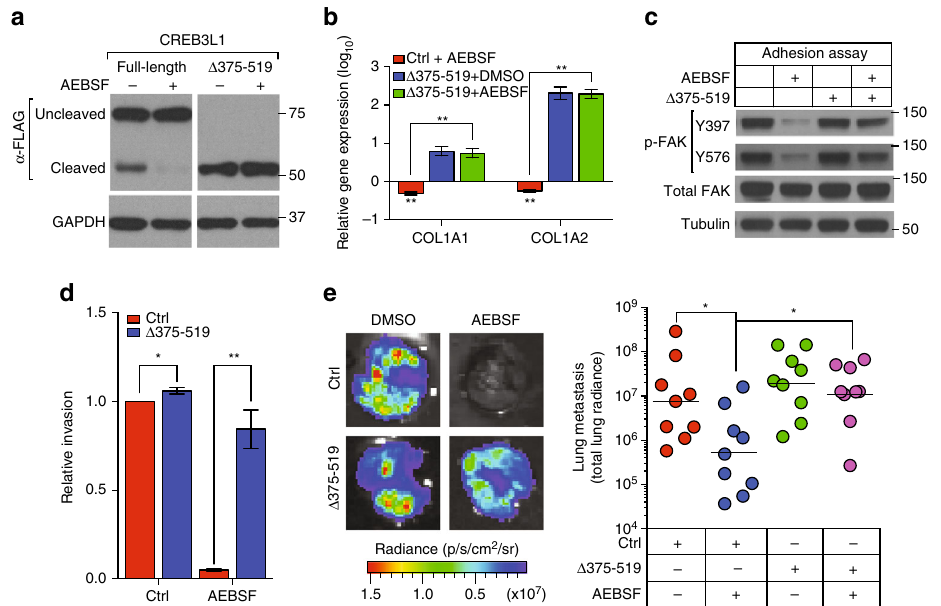
Fig. 4 Chemical inhibition of CREB3L1 blocks metastasis. a A western blot of CREB3L1 expression in full-length CREB3L1 or CREB3L1 Δ 375 – 519 transduced SUM159 cells that were treated with solvent control or a S1P inhibitor, AEBSF. b SUM159 cells transduced with control or CREB3L1 Δ 375 – 519 were treated with solvent control or AEBSF. qPCR analyses were performed to quantify the expression of ECM genes: COL1A1 and COL1A2 . The gene expression was normalized to the solvent-treated control transduction samples, n = 3. c Western blot of phosphorylated FAK (pY397 and pY576), total FAK, and Tubulin in cells of b . d Quanti fi cation of cell invasion of cells from b in a basement membrane-coated transwell assay, n = 3. e Two weeks after orthotopical transplantation with control or CREB3L1 Δ 375 – 519 transduced MDA.MB.231-Luc-LM2 cells, NOD/SCID mice were treated with solvent control or AEBSF for another 4 weeks. Lung metastases of the animals were gauged by radiance from the whole lung in each animal, n = 9. Data are represented as mean ± SEM or geometric mean alone. * indicates p < 0.05; ** indicates p < 0.01 (Student ’ s t upregulated in the metastatic growths of breast cancers that had disseminated to distant organ sites ( p < 0.01, Student's t -test; Fig. 3d, GSE20565, GSE20685, GSE7904, and GSE3744). Con- sistent with these fi ndings, nuclear and total CREB3L1 protein were expressed at signi fi cantly higher levels in the lymph node metastases of breast cancers, relative to primary breast tumors present on the same tissue microarray (Fig. 3e).